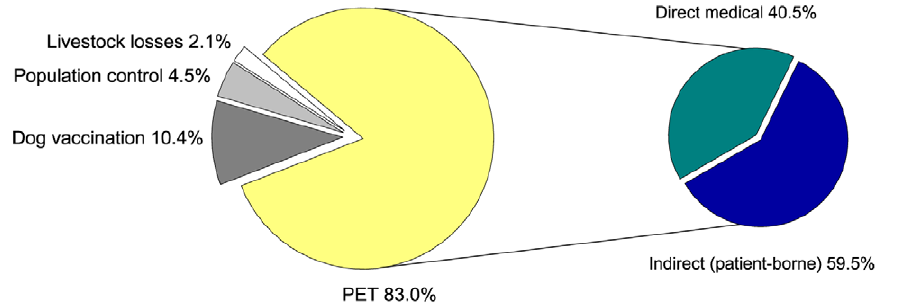
Figure 2. Economic burden of canine rabies (data source: LVII in Appendix S1). PET, Post-exposure treatment.